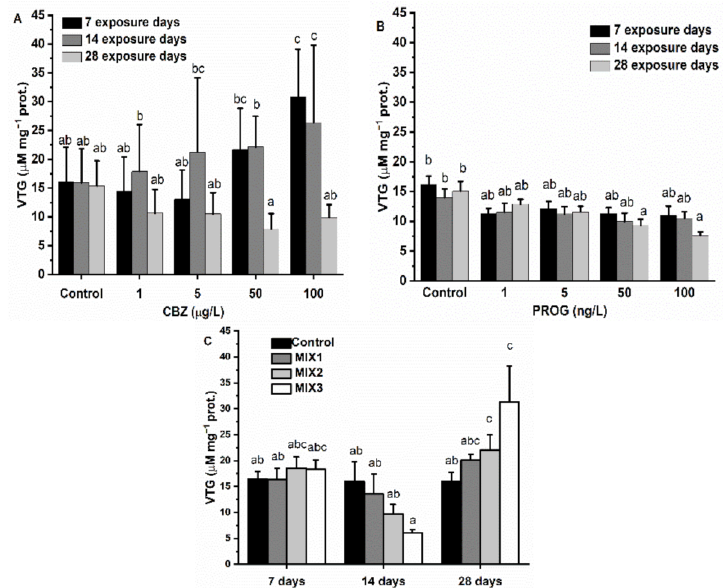
Figure 1. Changes in VTG content in the gonads of zebrafish exposed to ( A ) CBZ, ( B ) P4, and ( C ) binary mixtures of CBZ and P4 for 7, 14, and 28 days. Data are expressed as mean ± standard deviation of fifteen replicates ( n = 15). Different letters indicate significant differences at p < 0.05 after a two-way ANOVA followed by Tukey’s post hoc